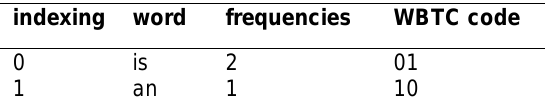
Table 14: Wt for Table 8